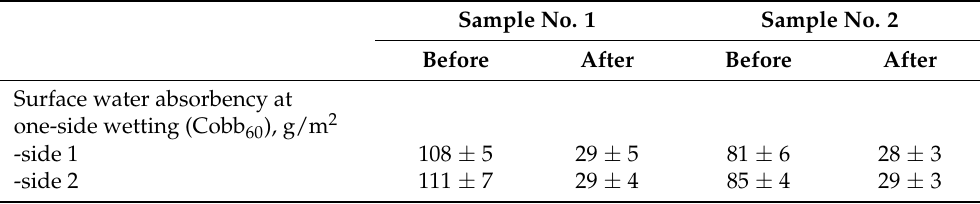
Table 4. Surface absorbency of paper sample nos. 1 and 2 before and after modification. Sample No. 1